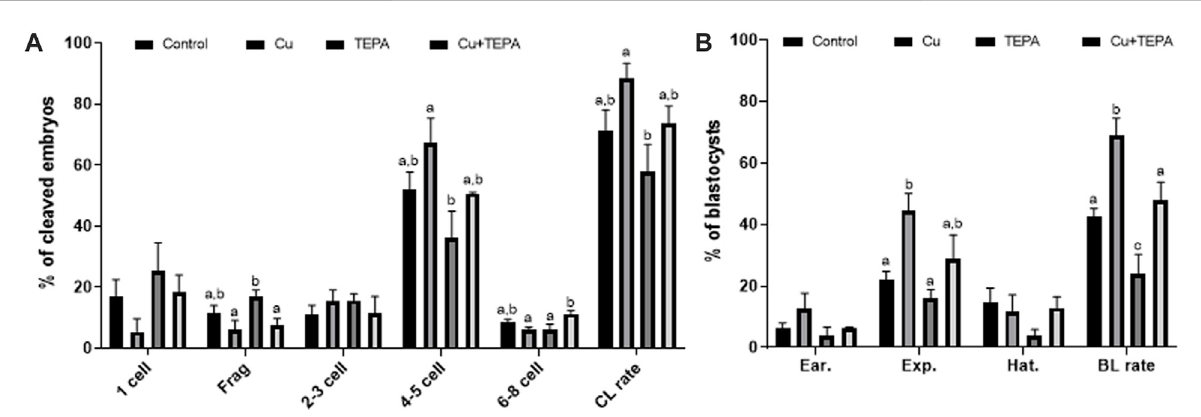
FIGURE 6 Effect of Cu chelation during in vitro maturation (IVM) on the cleavage pattern (A) and blastocyst formation pattern (B) of the parthenogenetic activation (PA) embryos. Within each endpoint, the bars with different letters (a – c) are signi fi cantly different ( p < 0.05) for various treatment conditions. Frag, Fragmentation; CL, cleavage; BL, blastocyst. The cleavage rate was measured on day 2, and the blastocyst formation rate was evaluated on day 7 of culture. For all graphs, the values represent the mean ± SEM. The experiment was replicated thrice.